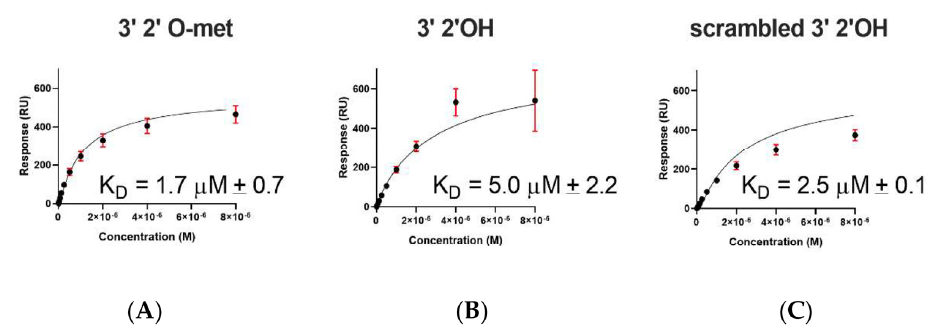
Figure 2. Affinity-binding equilibrium curves for AePiwi4 PAZ to piRNAs. Fitted affinity-binding equilibrium curves for AePiwi4 PAZ analyte to a 28 nt ( A ) 3 ′ 2 ′ O-methylated, ( B ) non-methylated, or ( C ) scrambled 28 nt non-methylated piRNA. Equilibrium K D was calculated from steady-state binding levels R eq = (CR max )/(K D + C) + offset, where C = concentration, R max = analyte-binding capacity of the surface in response units (RU), K D = dissociation constant, and offset = response at zero analyte concentration. M = molar concentration. Red bars indicate mean and standard deviation for R max values.